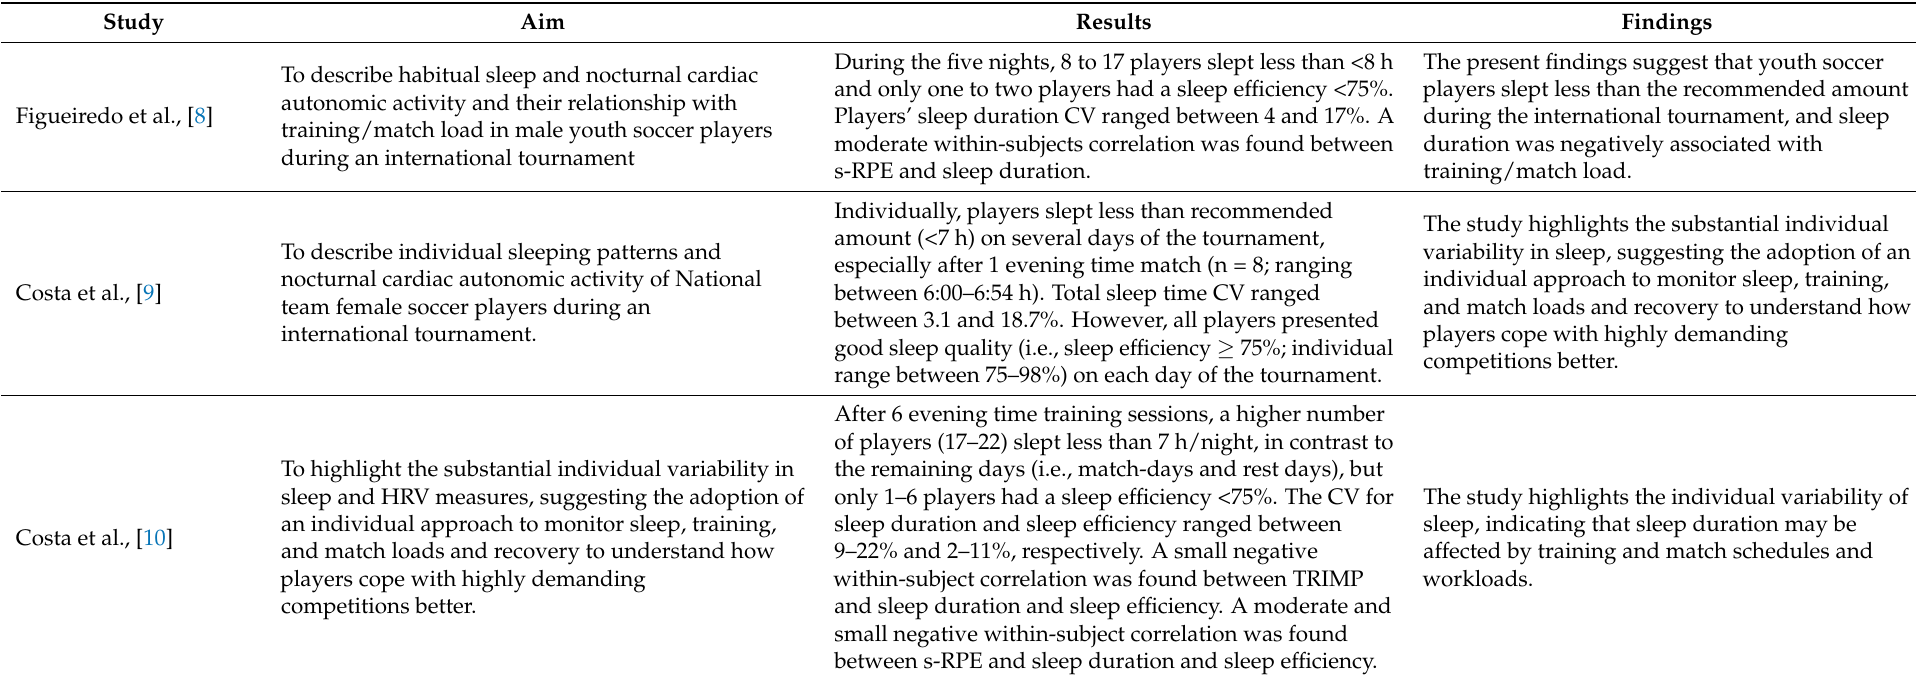
Table 6. Results concerning sleep and training/match